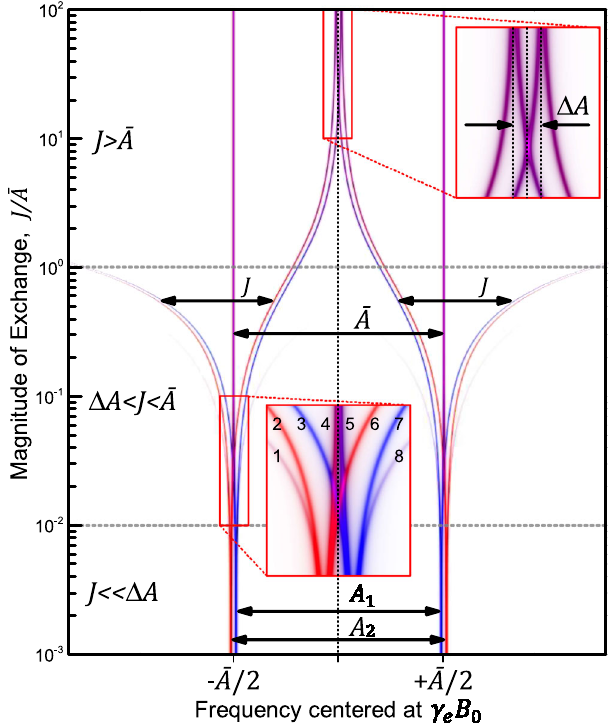
FIG. 3. The ESR fingerprint of H ð J Þ plotted as a function of the exchange-hyperfine interaction ratio. Branches are labeled from ¯ A line, with 1 to 8 left to right (1 to 16) on the J ¼ 10 − 1